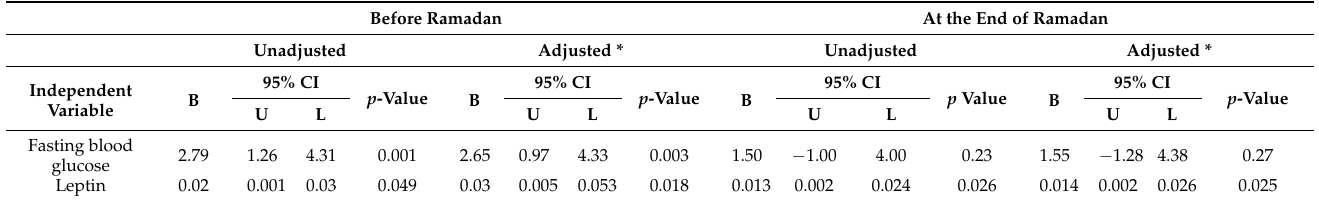
Table 6. Linear regression analysis using PCSK9 as a dependent variable and fasting blood glucose and leptin as independent variables. Before Ramadan At the End of